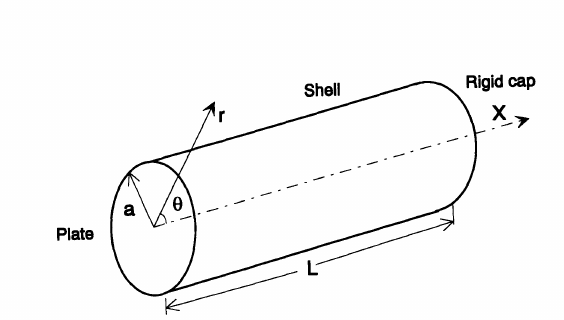
FIGURE 2 Schematic diagram of the structure un der